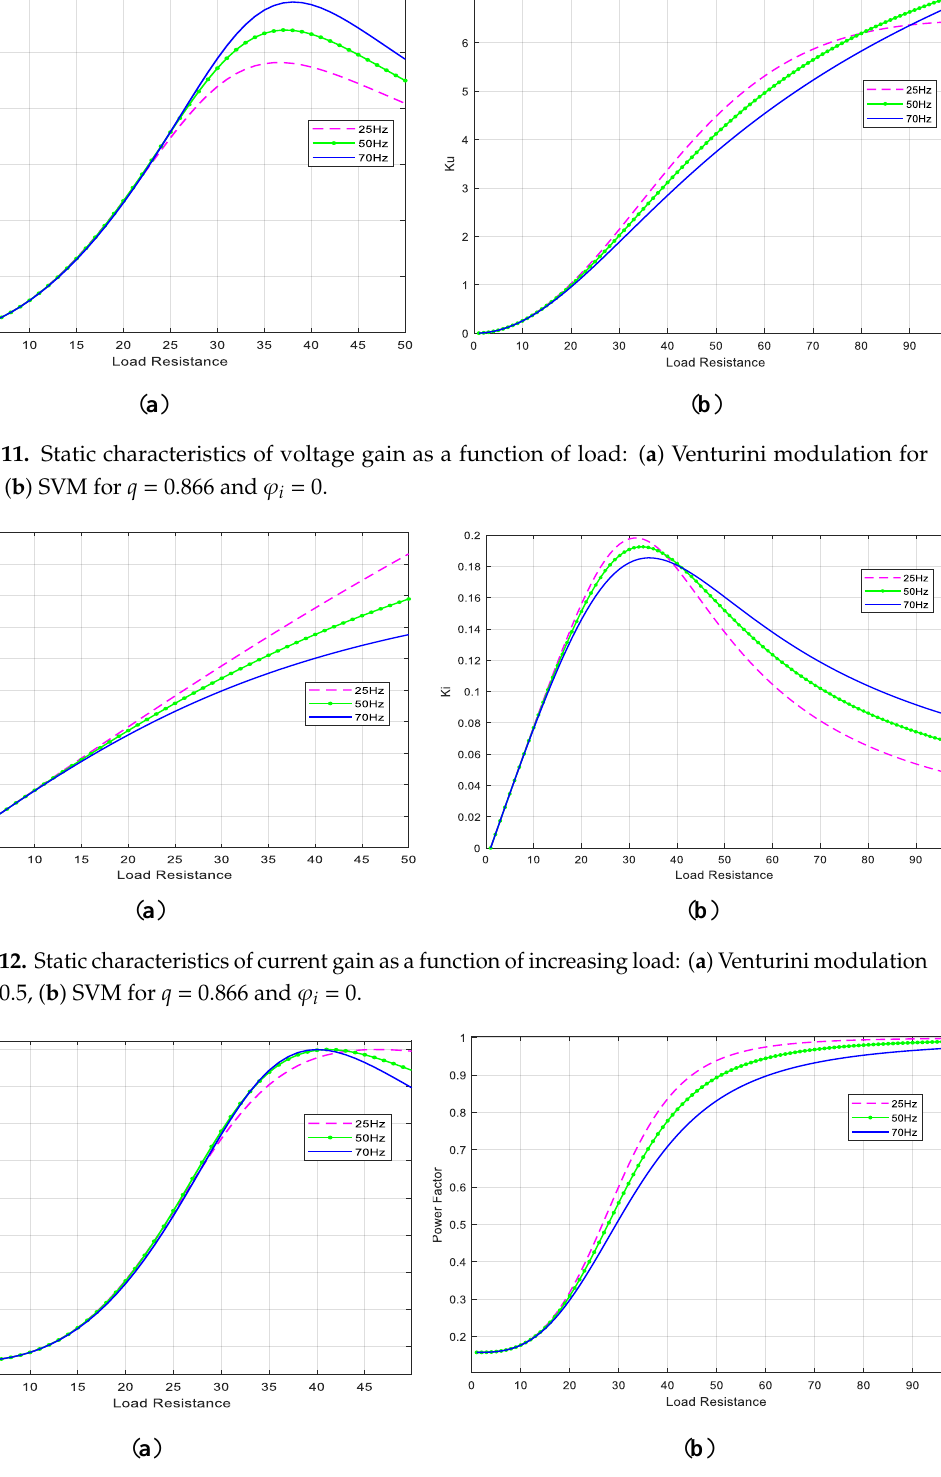
Figure 13. Static characteristics of power factor gain as a function of increasing load: ( a ) Venturini modulation for q = 0.5, ( b ) SVM for q = 0.866 and φ i = 0 .